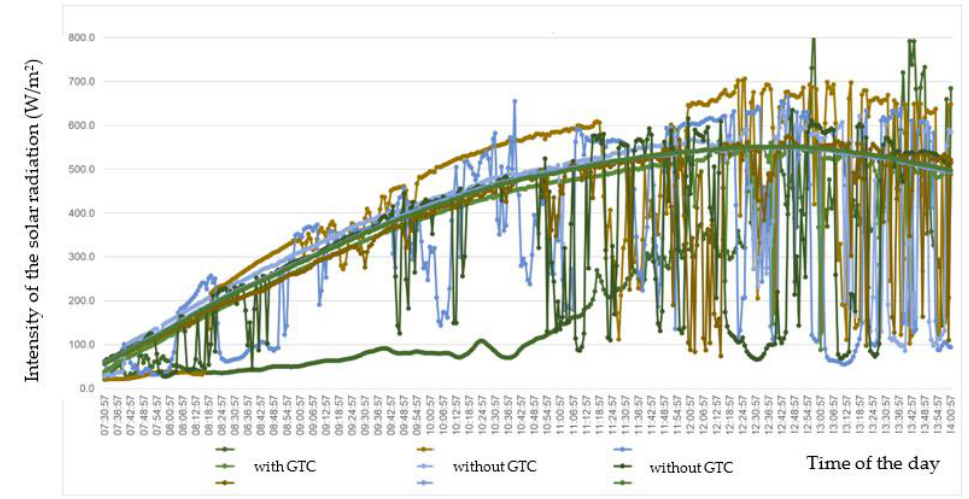
Figure 11. Solar radiation intensity for several days during the experimental tests.